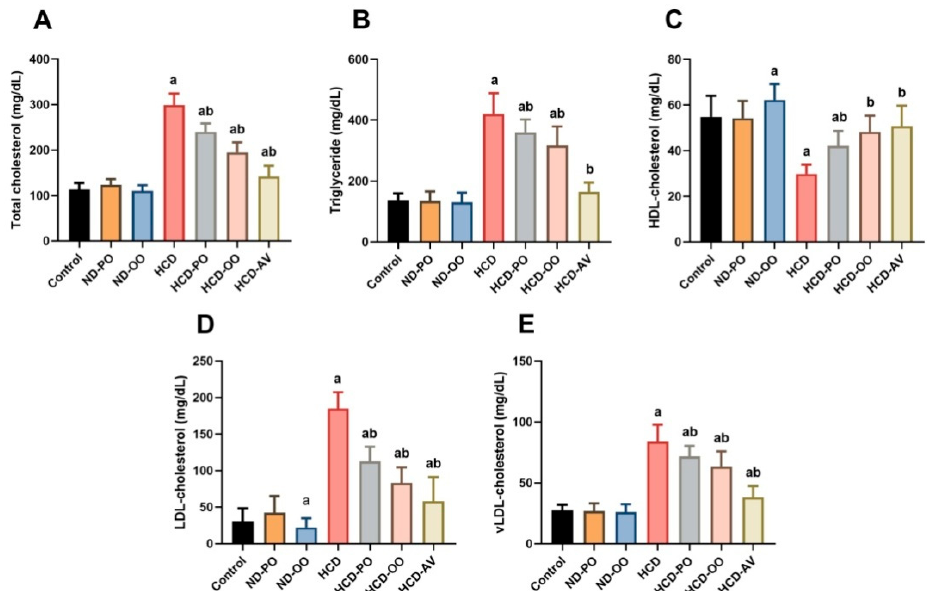
Figure 3. Serum levels of ( A ) triglyceride, ( B ) cholesterol, ( C ) HDL, ( D ) LDL, and ( E ) vLDL following treatment with palm oil (PO), olive oil (OO), or atorvastatin (AV) in high-cholesterol diet-induced hypercholesterolemia in rats. Data are expressed as the mean ± SD ( n = 7). Letters a and b indicate statistically significant differences between control rats and hypercholesterolemia rats, respectively, at p < 0.05.